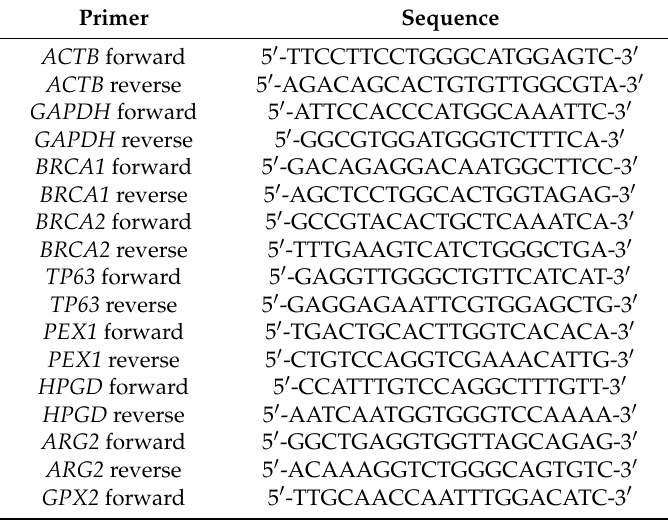
Table 1. Primer sequences of the investigated